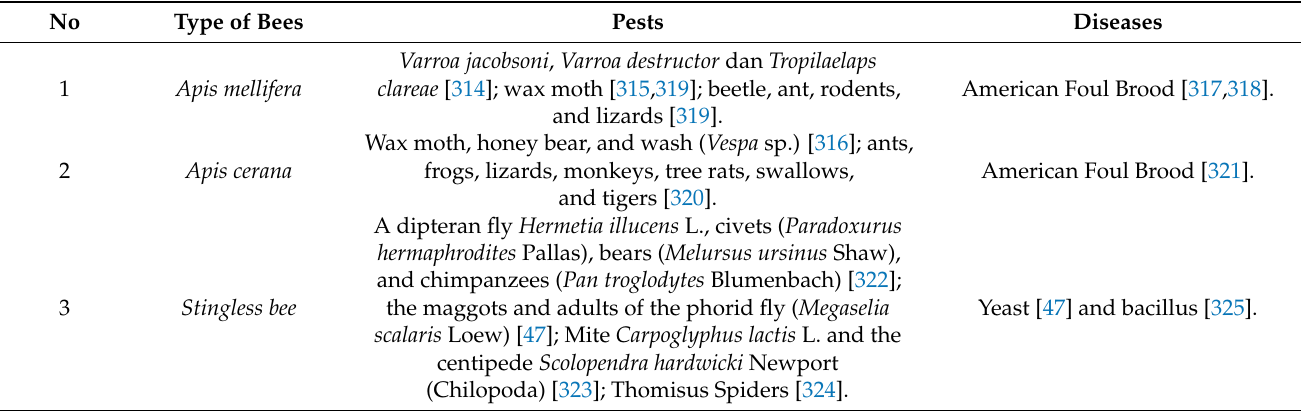
Table 4. Pests and diseases of honeybees and stingless